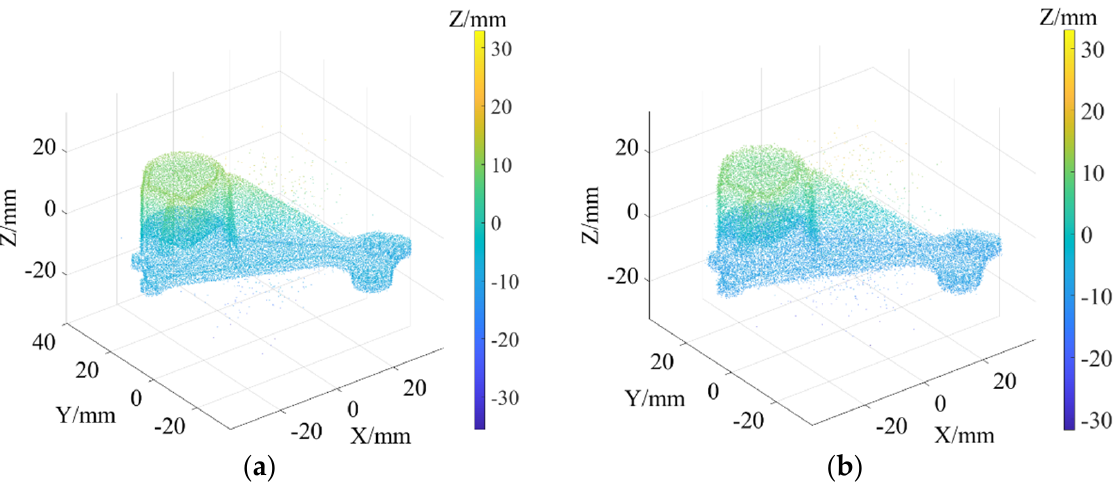
Figure 4. Point cloud models under different noise intensities: ( a ) noise ( σ = 0.2 ) ; ( b ) noise ( σ = 0.4 ) .